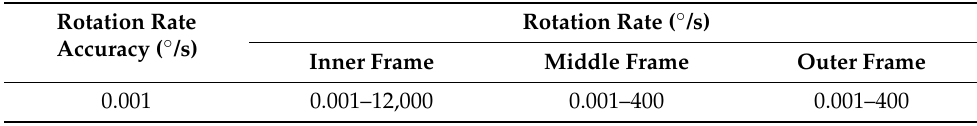
Figure 22. The experimental equipment: ( a ) the experimental equipment; ( b ) configuration of experimental swing state. Table 8. Technical parameters of flight simulation turntable.